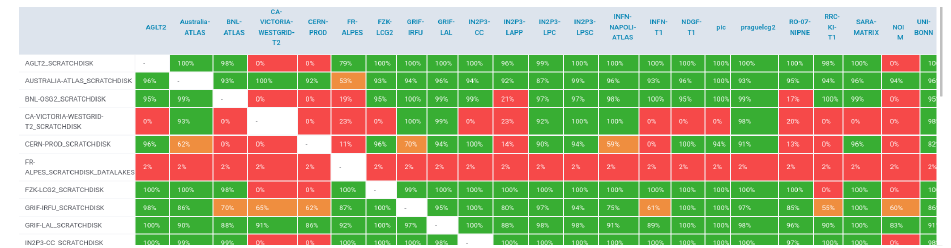
Fig. 2. An example DOMA TPC dashboard showing the HTTP TPC functional test results.